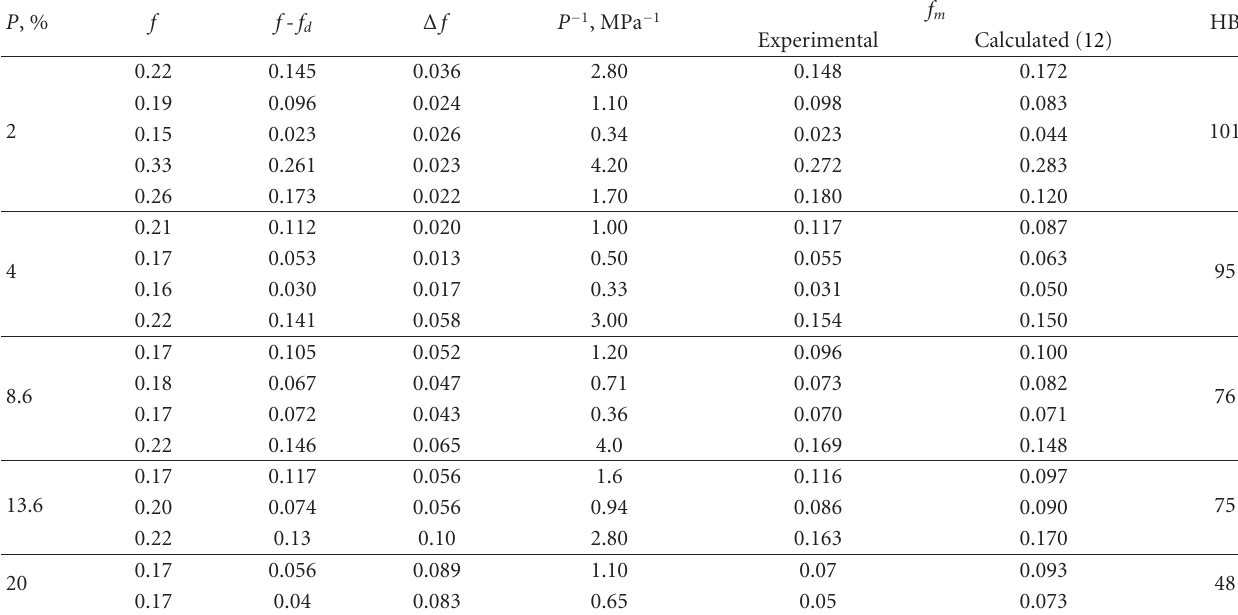
Table 3: Iron powder wear characteristics.